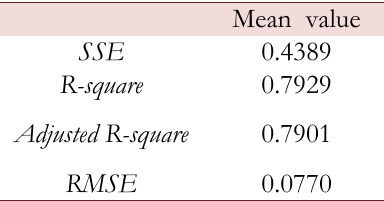
Table 10: Goodness-of-fit statistics of master S-N curve by using Eq.SS